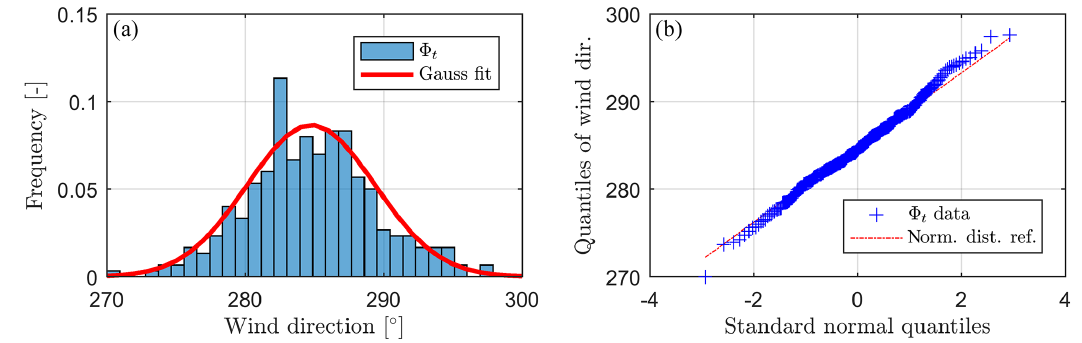
Figure 3. (a) Histogram of exemplary 5min wind direction measurements in blue with the fitted Gaussian normal distribution in red, (b) quantile–quantile plot of the exemplary 5min wind direction measurements in blue with the normal distribution reference represented by the dashed red